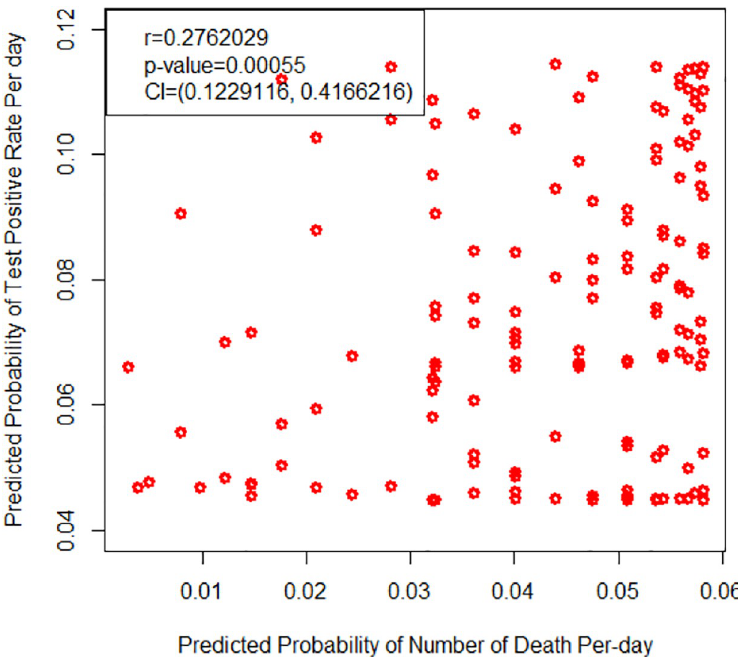
Fig 4. Relationship between predictive prob-ability of number of death and test positive